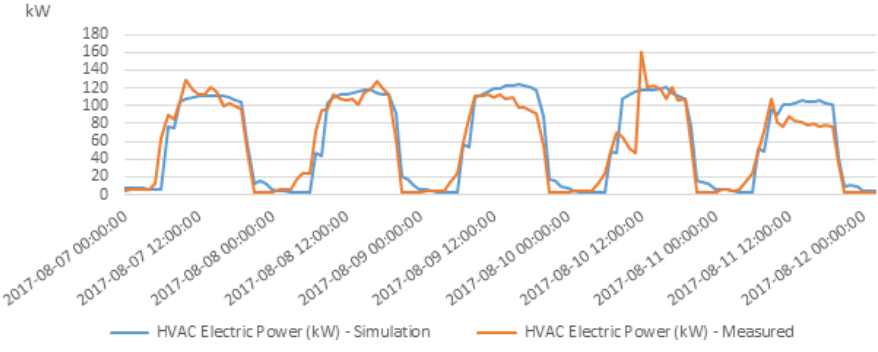
Figure 4. Simulated vs. measured HVAC electric power for the week from 7/8/17 to 11/8/17. Following parameterization of the model monthly deviation in HVAC, electric energy consumption are minimized to a percentage difference ranging from 1.78% in February to 30.28% in September and an acceptable CVRMSE of 13.89% (Figure 5b). Total simulated HVAC electric energy in this optimized case is 252,689 kWh or 221,946 kWh excluding weekends associated to a percentage difference of 11.5% and 4.6%, respectively.